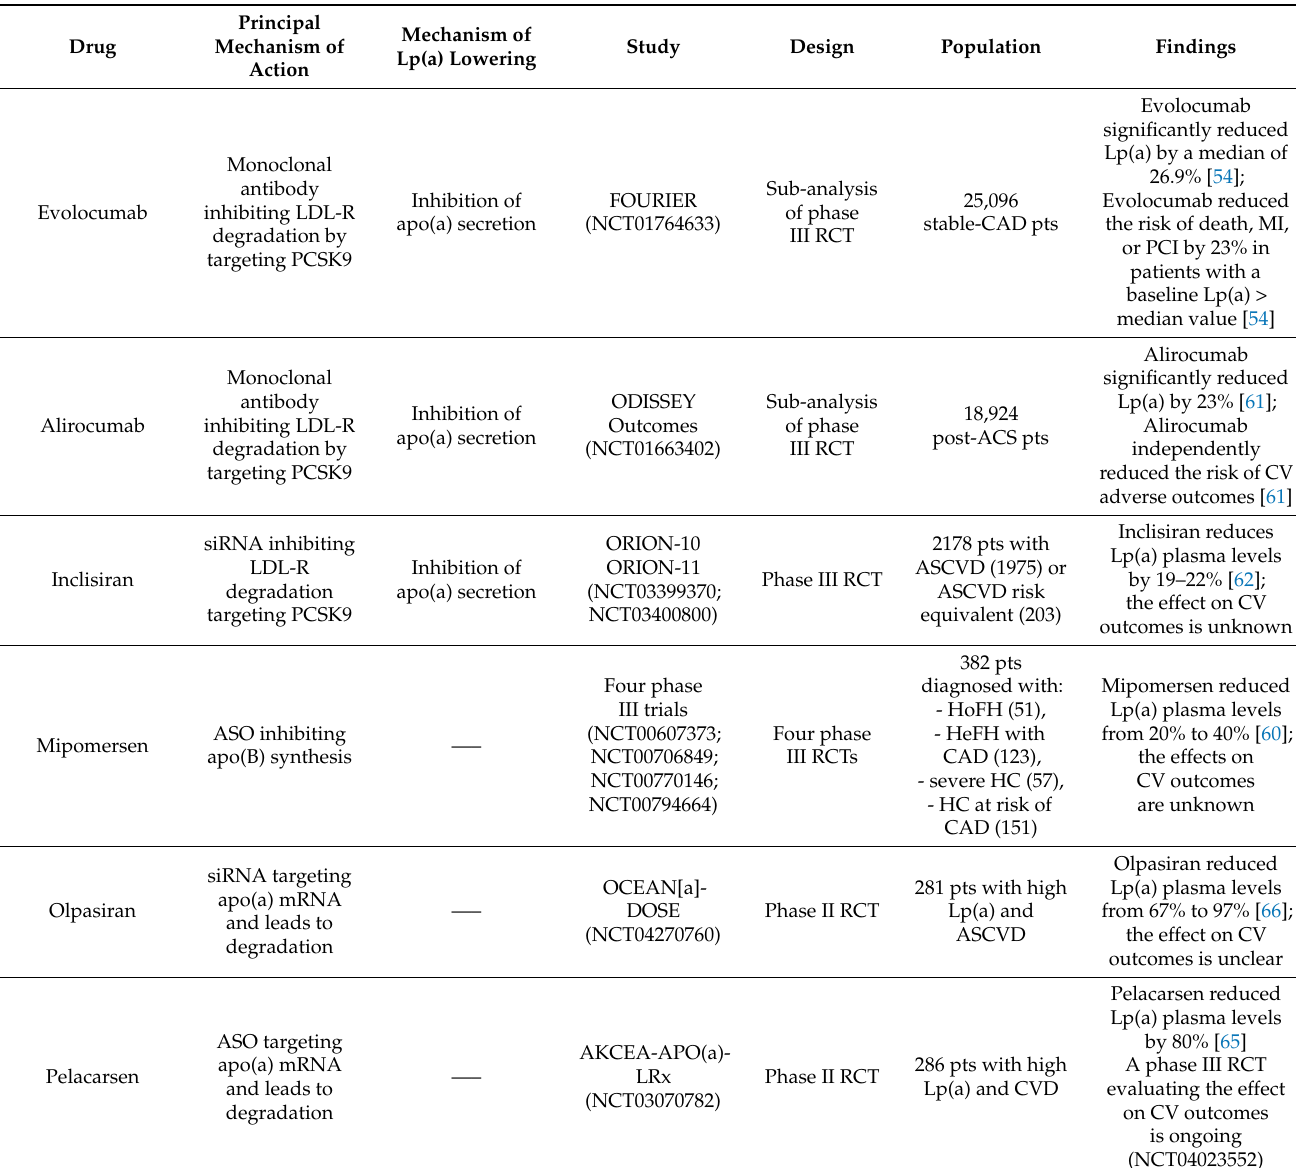
Table 1. Emerging therapies for lowering Lp(a) serum